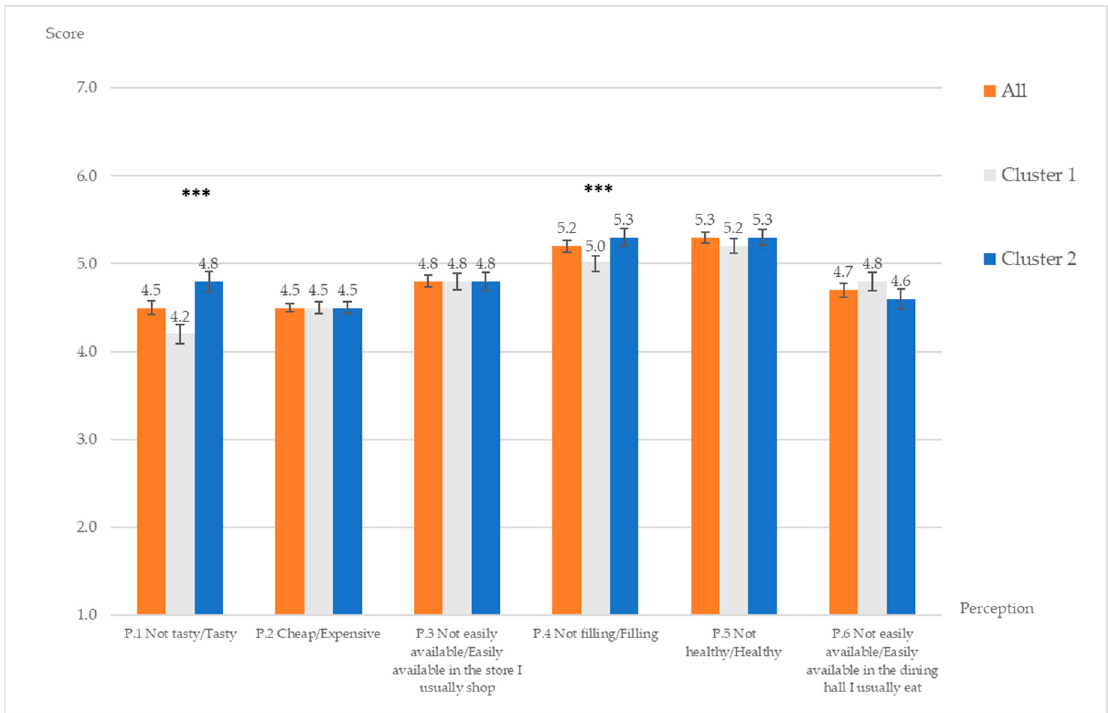
Figure 1. Perception of whole grain pasta in the sample, Cluster 1 (Uninvolved) and Cluster 2 (Health-conscious). Results from Mann–Whitney U test between 2 clusters *** significant at the 0.01 level.